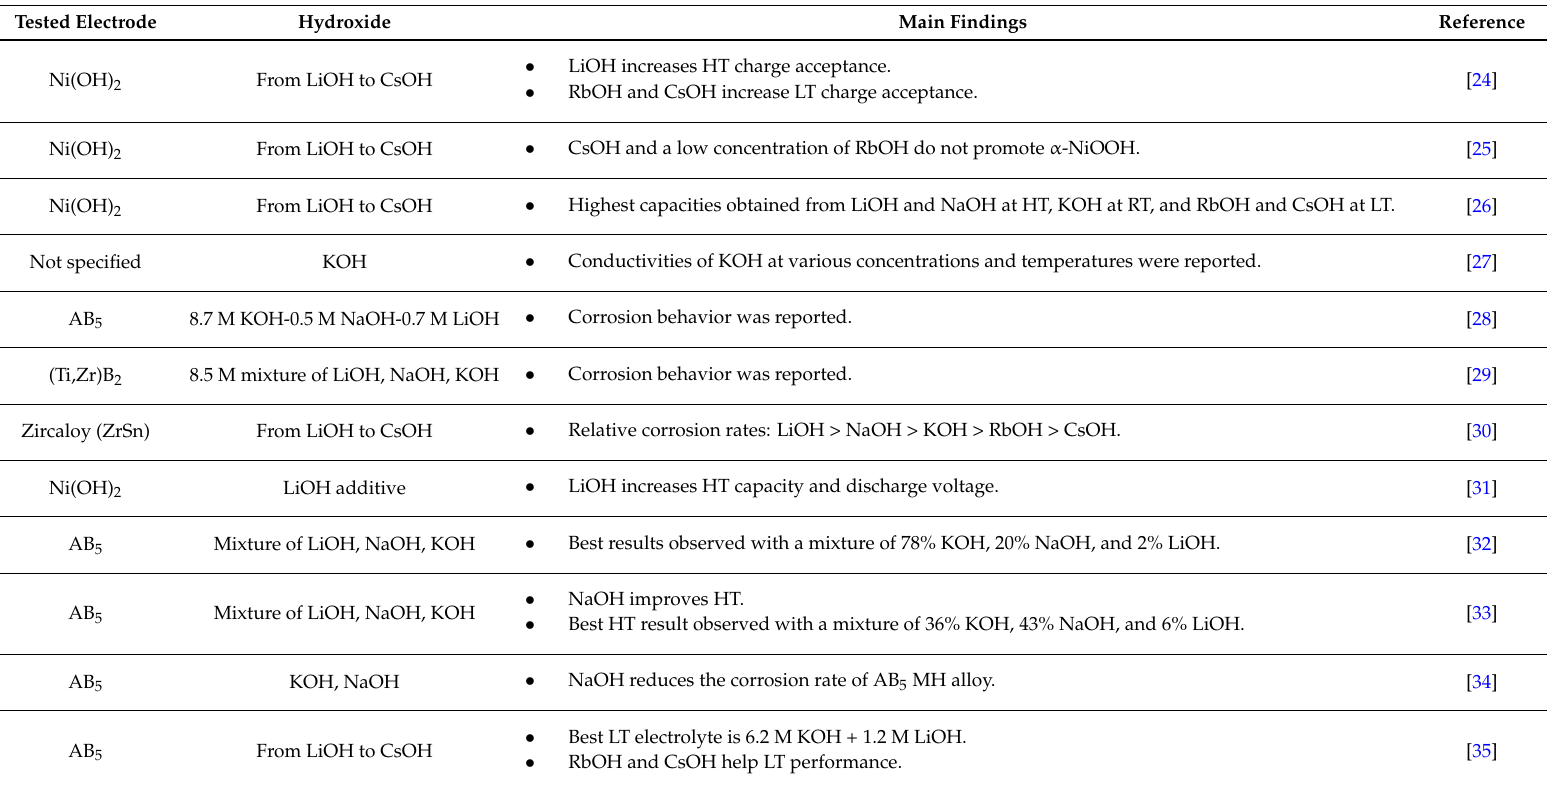
Table 1. Summary of previous electrolyte studies on alkali cations in a chronological order. LT, RT, and HT denote low temperature (<0 ◦ C), room temperature, and high temperature (>40 ◦ C), respectively. A and B in the alloy formula represent misch metals (La, Ce, Pr, and/or Nd) and transition metals (Ni, Co, Mn, and/or Al), respectively. MH: metal hydride; and HRD: high-rate